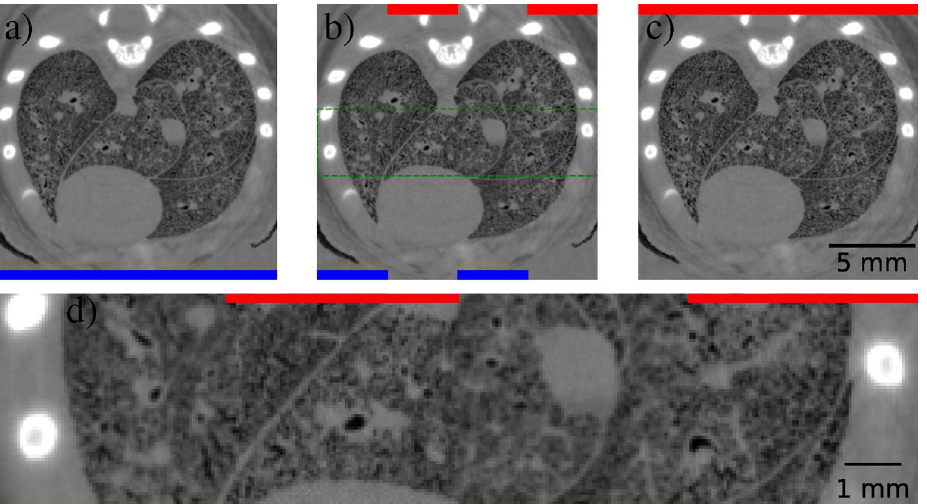
Figure 5. CT slices of a rat lung reconstructed from phase retrieved projections using either the ( a ) PM or ( c ) GPM algorithms. ( b ) Shows an interleaved image of the two methods, with a blue band along the bottom in columns from the PM method and a red band along the top in columns from the GPM, with an inset region in ( b ) bounded by dashed green lines magnified in ( d ) for direct comparison of the two